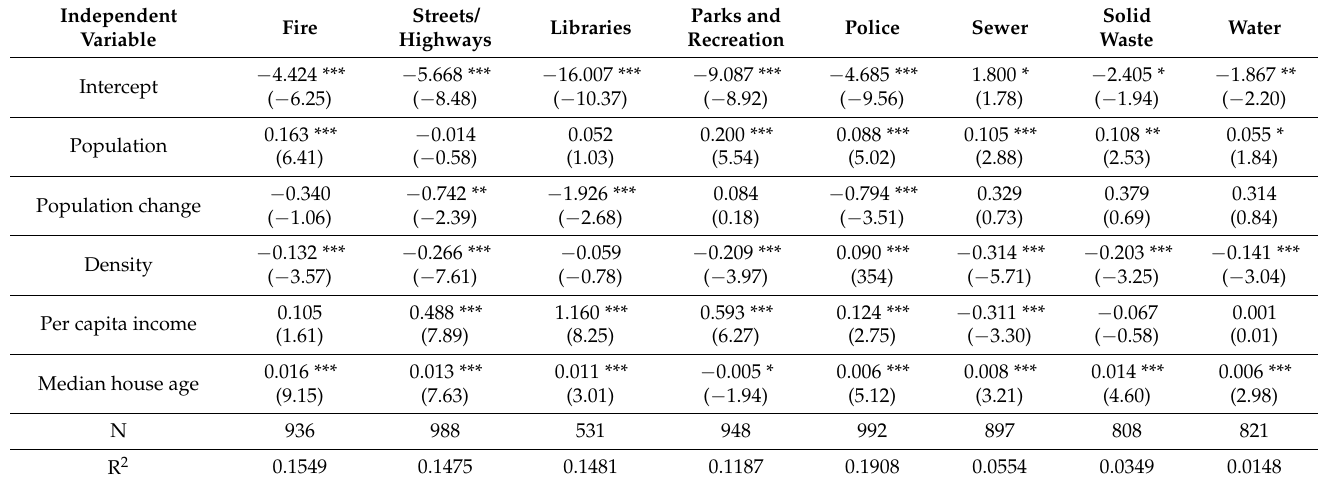
Table 3. Results for models of per capita municipal expenditures, operational costs.